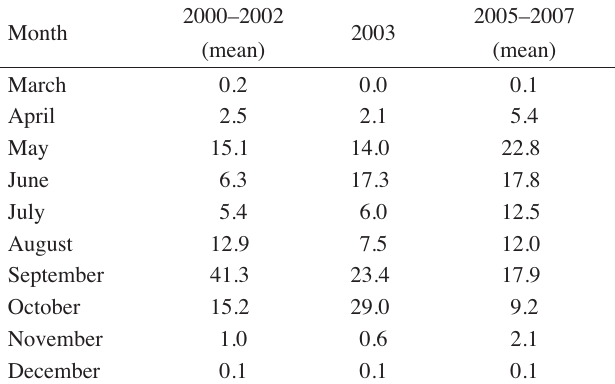
Monthly percentage of eel landings in different